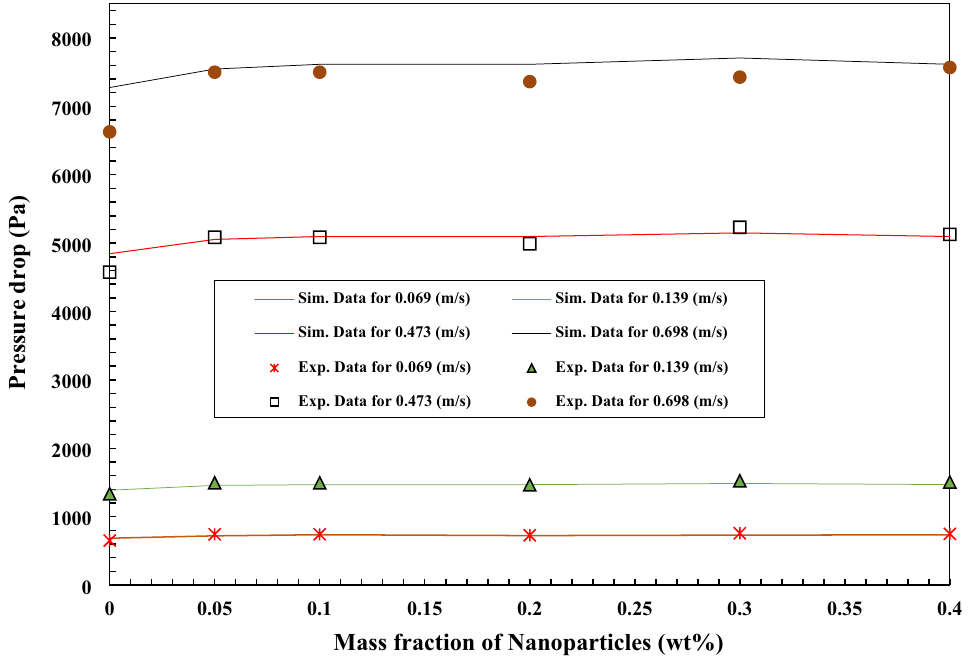
Figure 22. Comparison of experimental and simulation data of the pressure drop of the nanofluids in different mass fraction of MWCNTs nano additives.